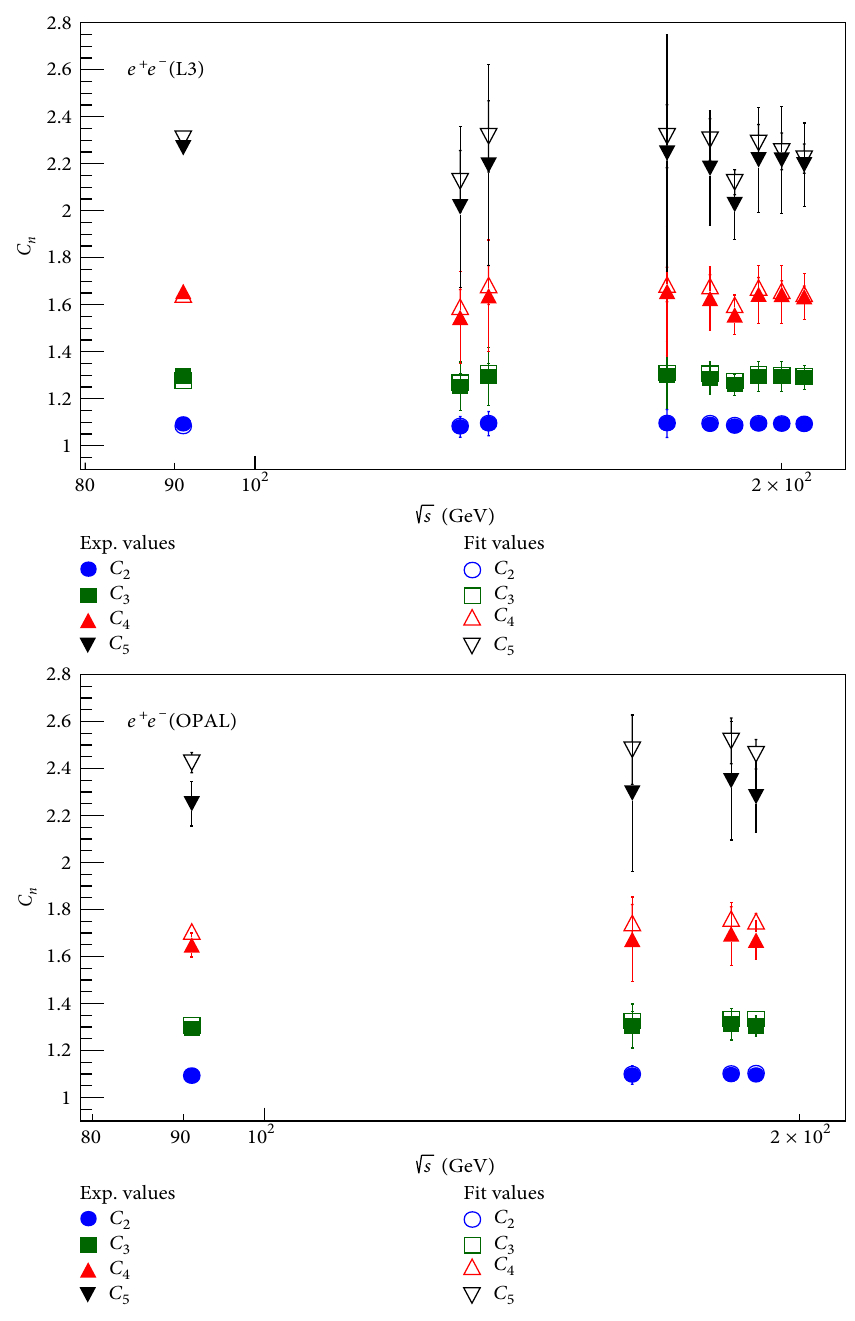
+ − collisions recorded by the L3 and OPAL experiments at different 𝑒 𝑒